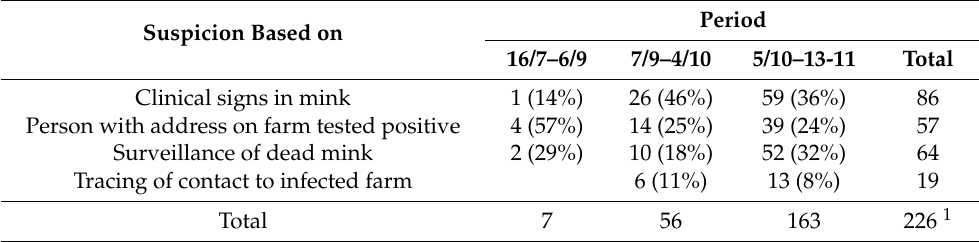
Table 1. Suspicion of SARS-CoV-2 in mink based on different reporting mechanisms in 215 Danish mink farms in different periods of the epidemic. Period Suspicion Based on 16/7–6/9 7/9–4/10 5/10–13-11 Clinical signs in